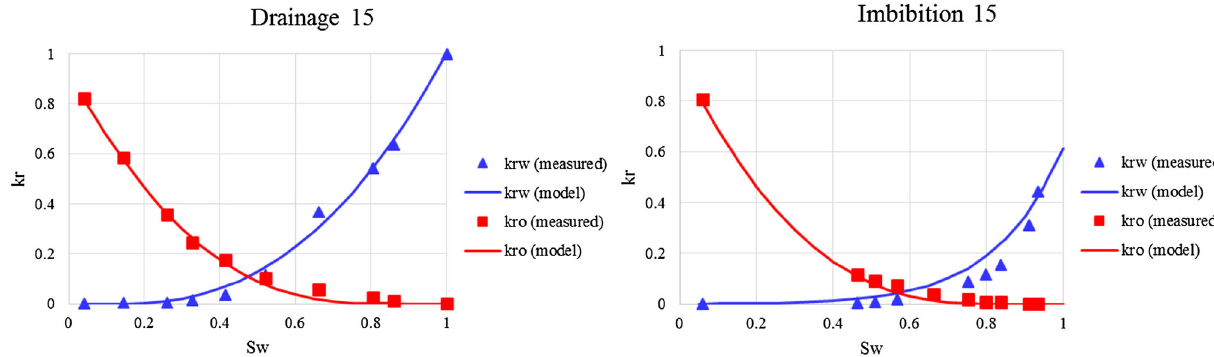
Fig. 13 Drainage and imbibition K r correlation for sample plug #15